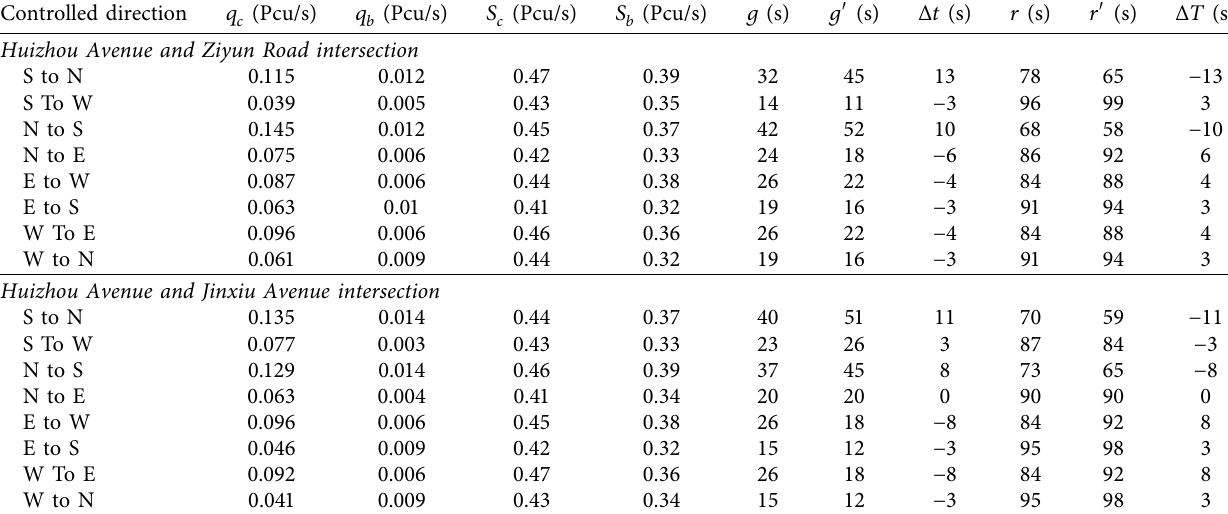
Table 2: Traffic survey data and the signal adjustments at intersections.